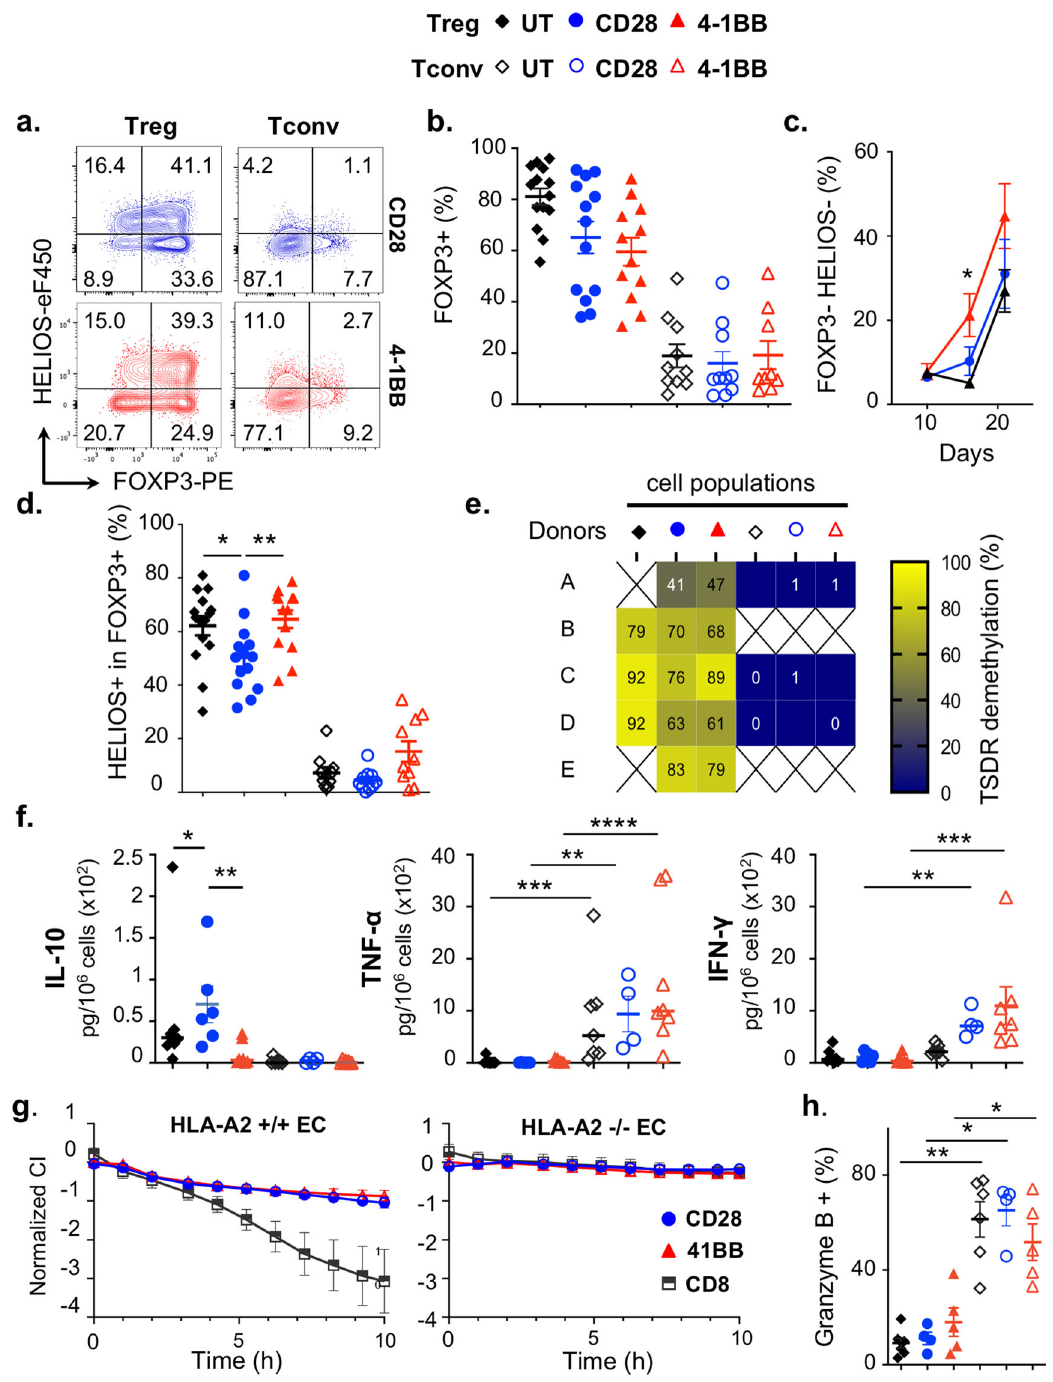
polyclonal Tregs (transduced with an EGFRt-expressing vector, referred to as MOCK-Tregs) with respect to